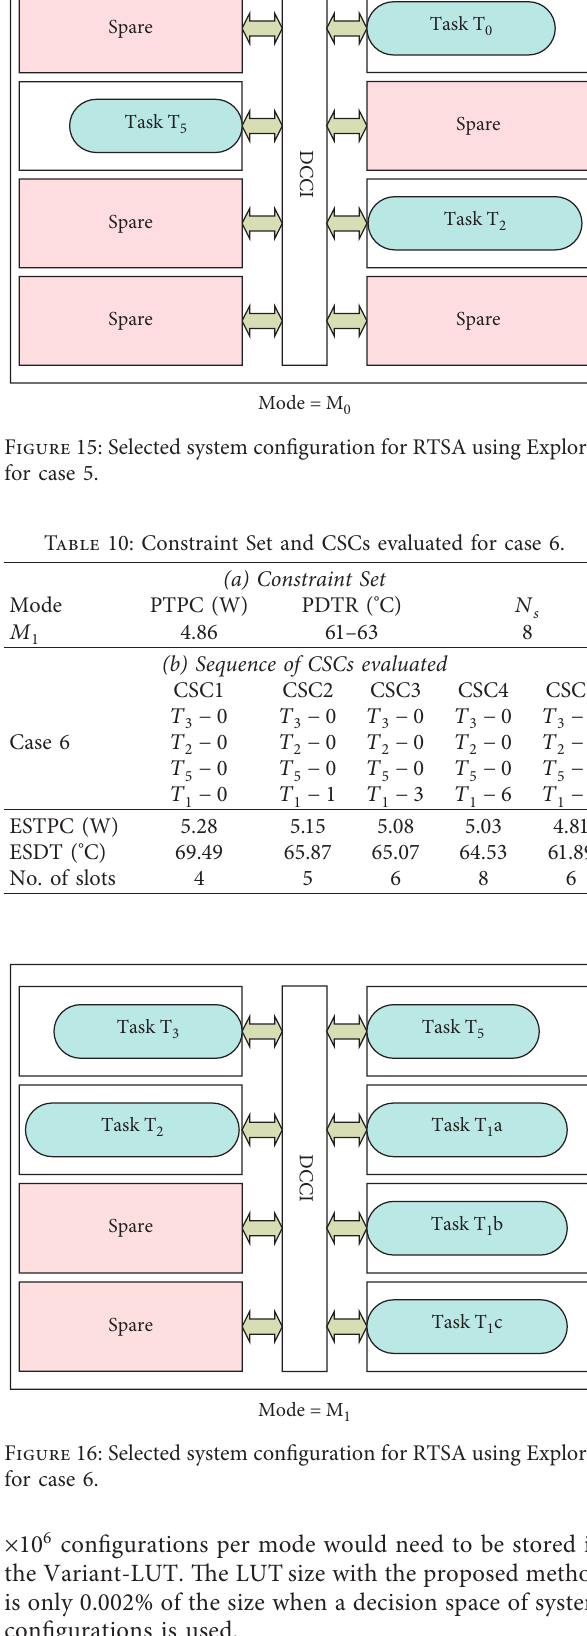
Table 11: Constraint Set and CSCs evaluated for case 7. (a) Constraint Set